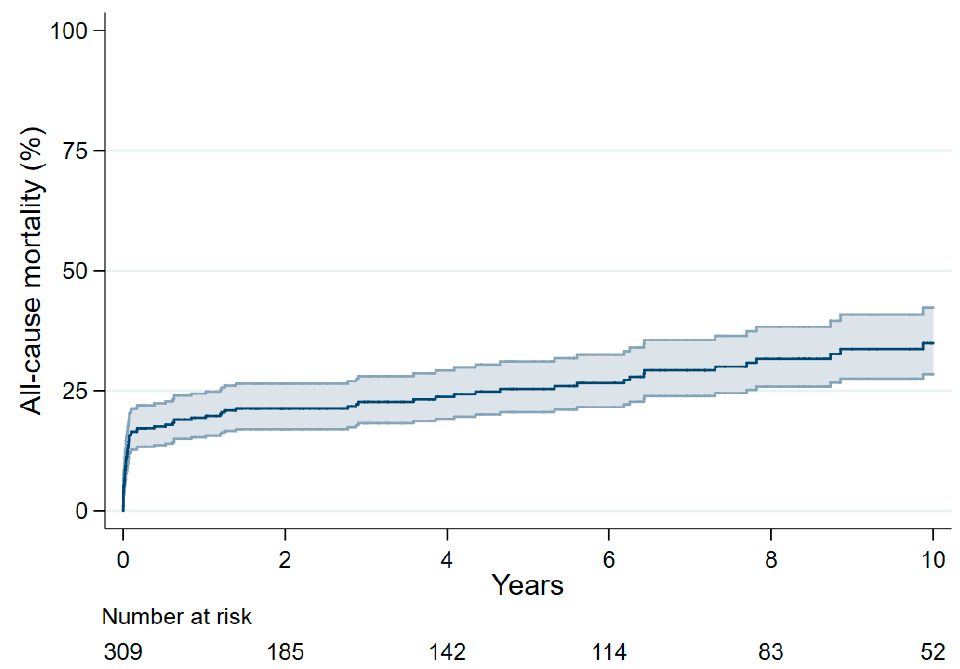
Figure 1. Survival after surgical repair of Stanford type A aortic dissection.